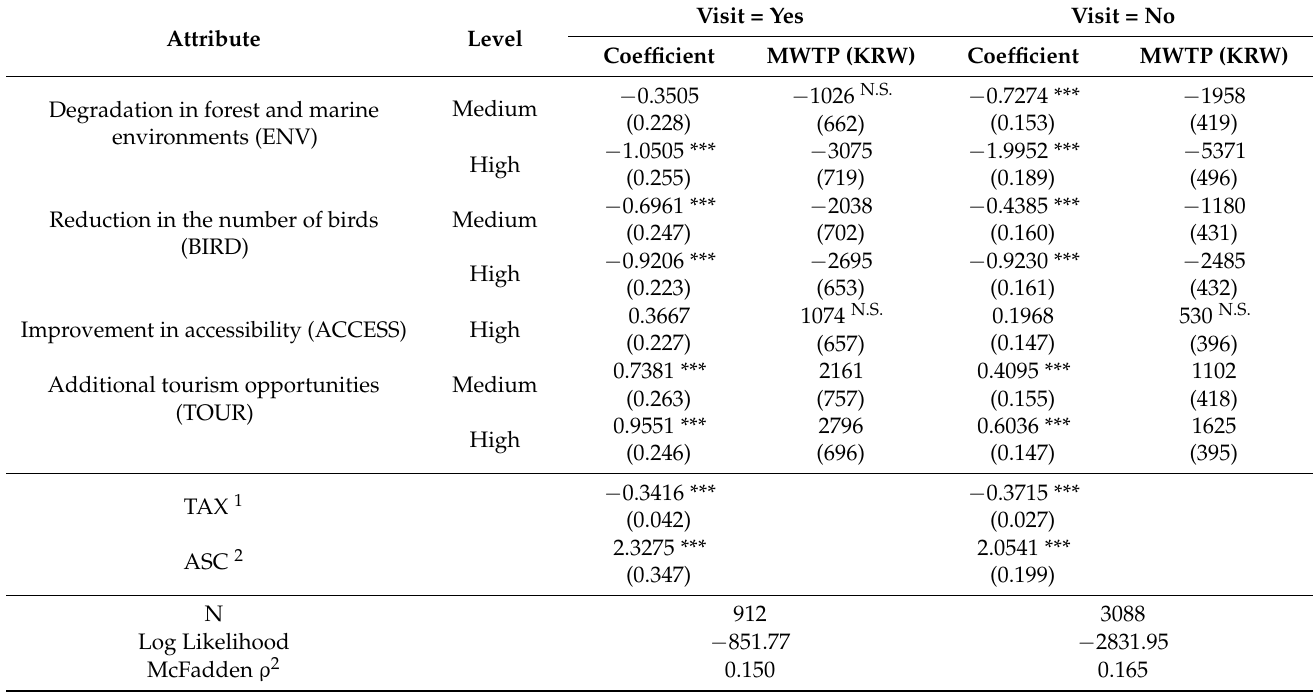
Table 4. Results of the random parameter model and the marginal willingness-to-pay (MWTP) of segmented groups (visit